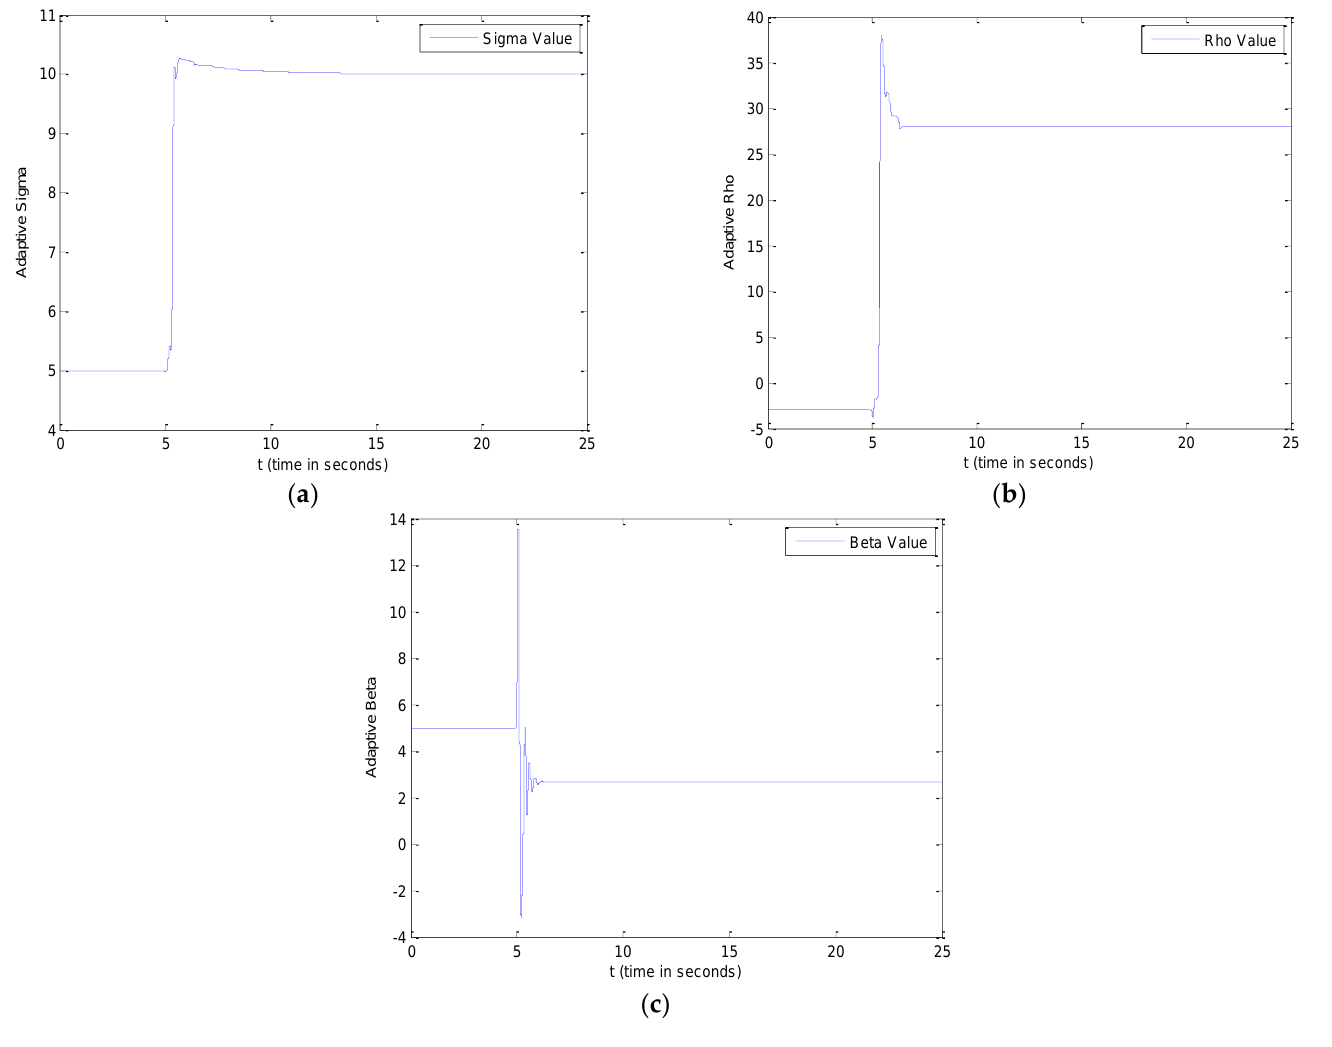
Figure 9. Graphs of synchronization (𝐚) 𝜎, (𝐛) 𝜌 and ( c ) β values of slave systems with 𝛼 𝑖 = 0.9, 𝑖 = 1, 2, and 3 , and time delay 𝜏 = 5 s.